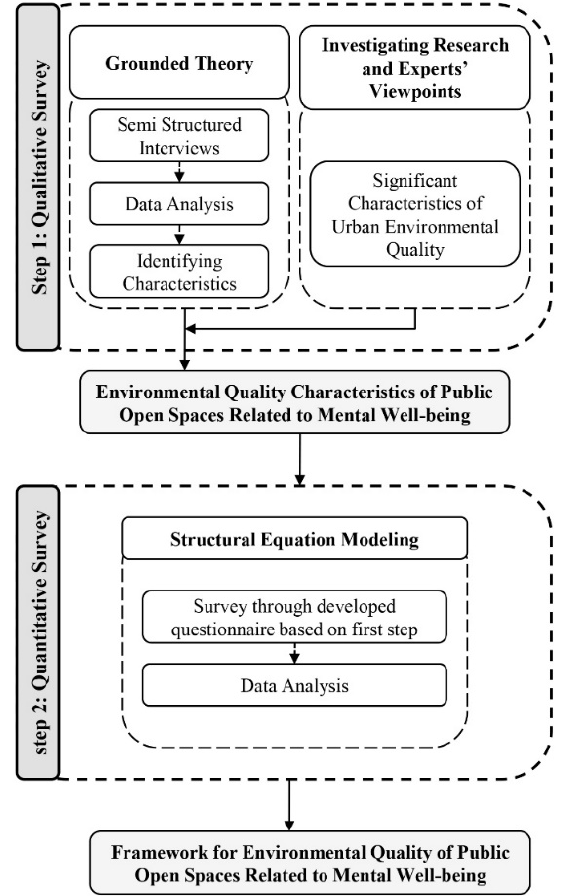
Figure 1. The diagram of encompassing methodology and process of this research.